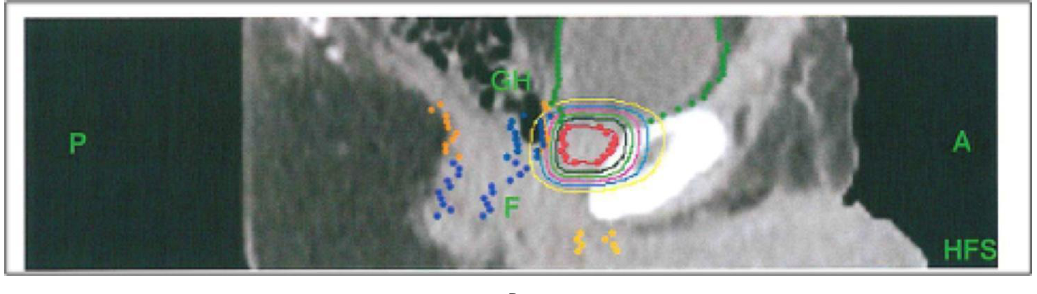
Figure 1. Patient characteristics: 79 yo, radical prostatectomy (RP) + radiotherapy (RT) in 2017, PSA increase 0.87 ng / mL (July 2018). ( A ) local relapse in left prostatic bed in prostate-specific membrane antigen-based positron emission computed tomography hybrid imaging ( 68 Ga-PSMA-11 PET / CT). ( B – D ) GTV and PTV contoured according to 68 Ga-PSMA-11 PET / CT in axial, coronal, and sagittal planes. (A: anterior; P: posterior; R: right: L: left; GH: gantry head; F: feet; HFS: head first supine). Anatomic structures: blue line: rectum anterior wall, orange line: rectum posterior wall; light blue line: right femur; green line: left femur. Cumulative isodose lines: red 18 Gy, dark green 15 Gy, light green 12 Gy, pink 9 Gy, blue 6 Gy and yellow 3 Gy.